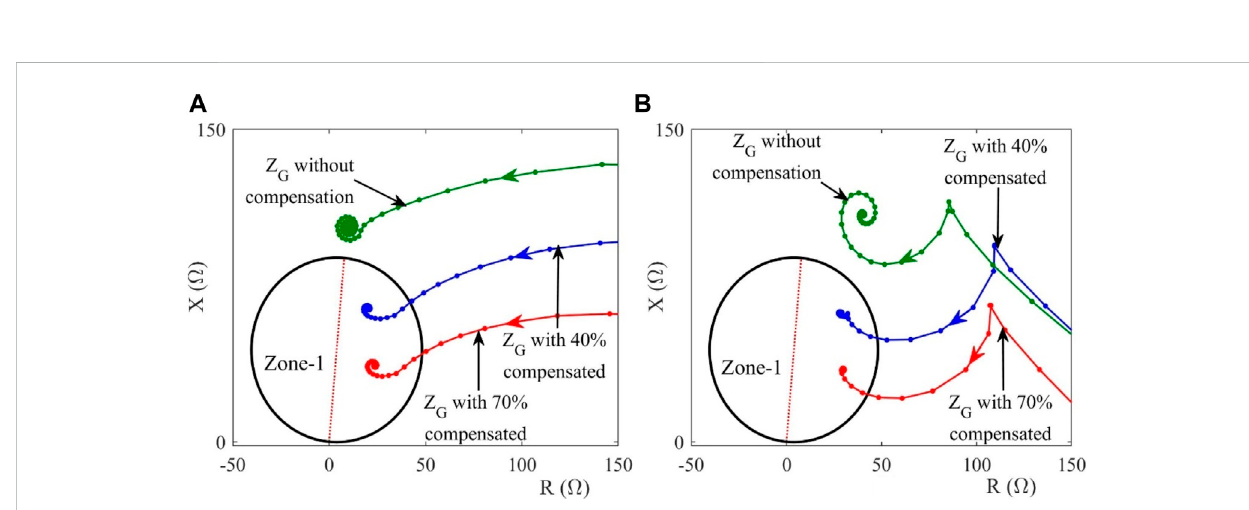
FIGURE 4 Demonstration of the impacts of balanced and unbalanced ground faults on relay R G during (A) abcg-fault and (B)